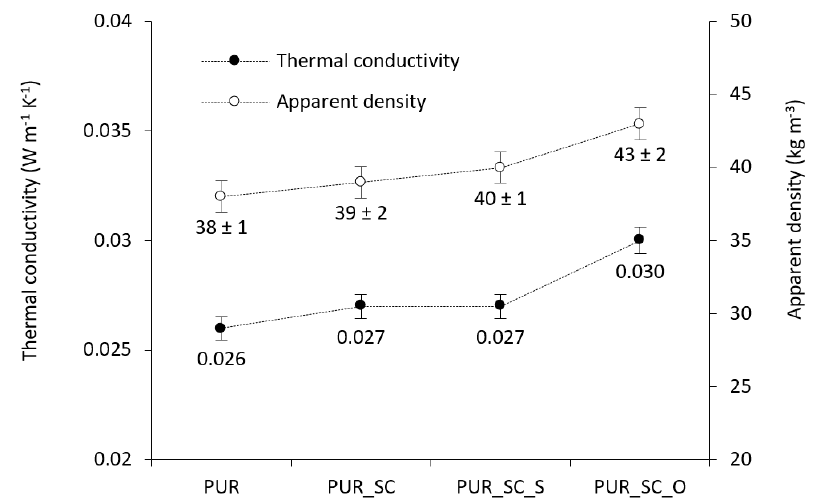
Figure 3. The impact of SC fillers on the apparent density and insulating properties.